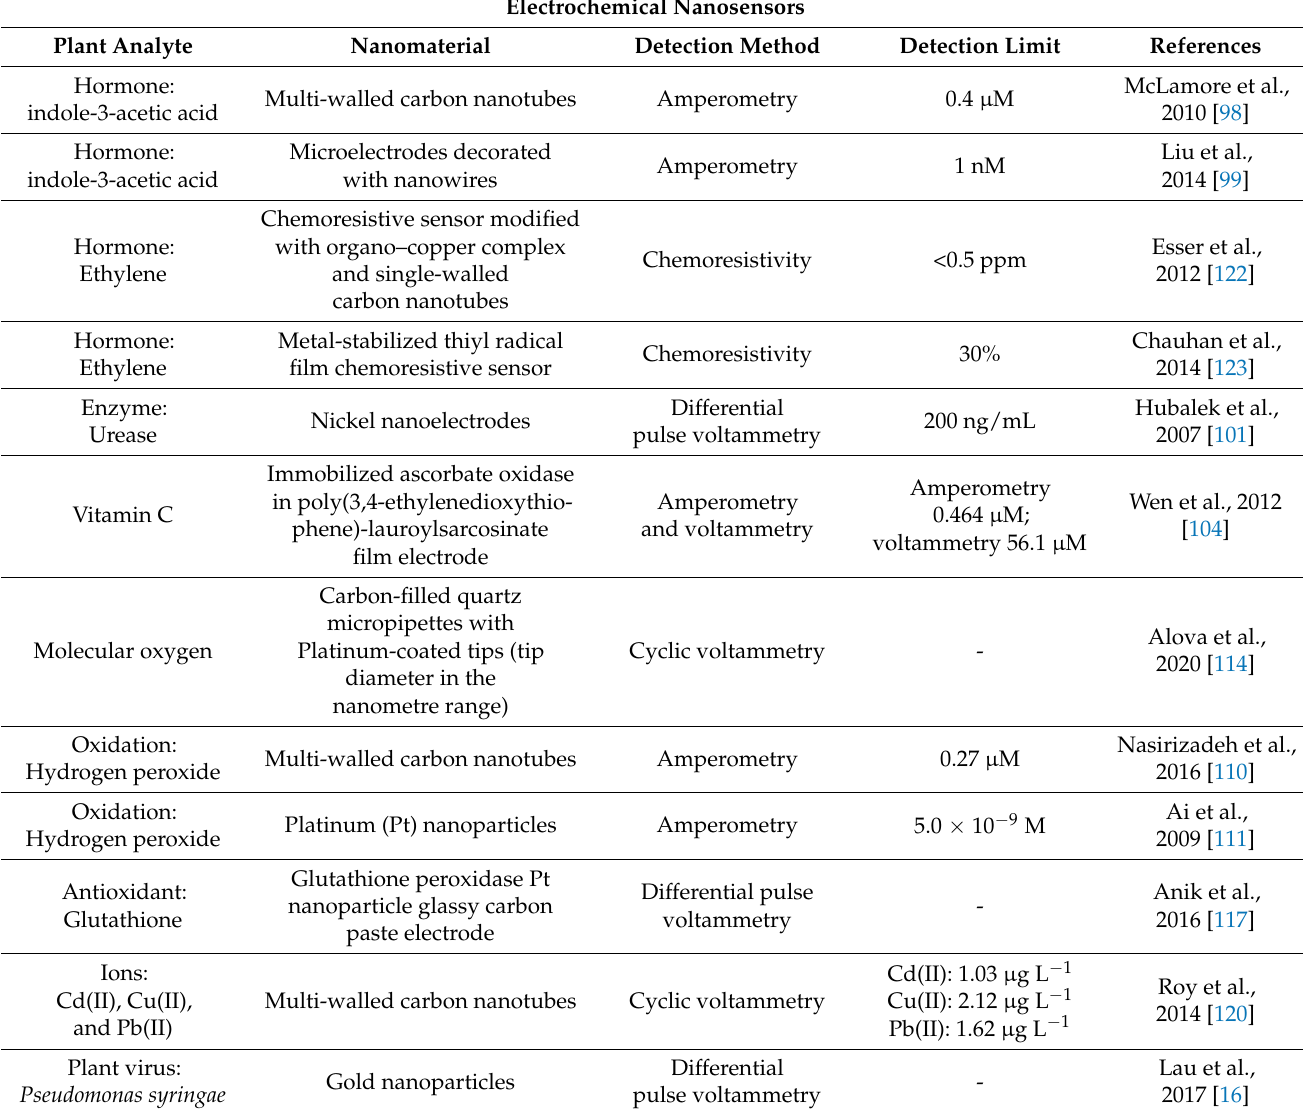
Table 4. Plant analytes determined with electrochemical